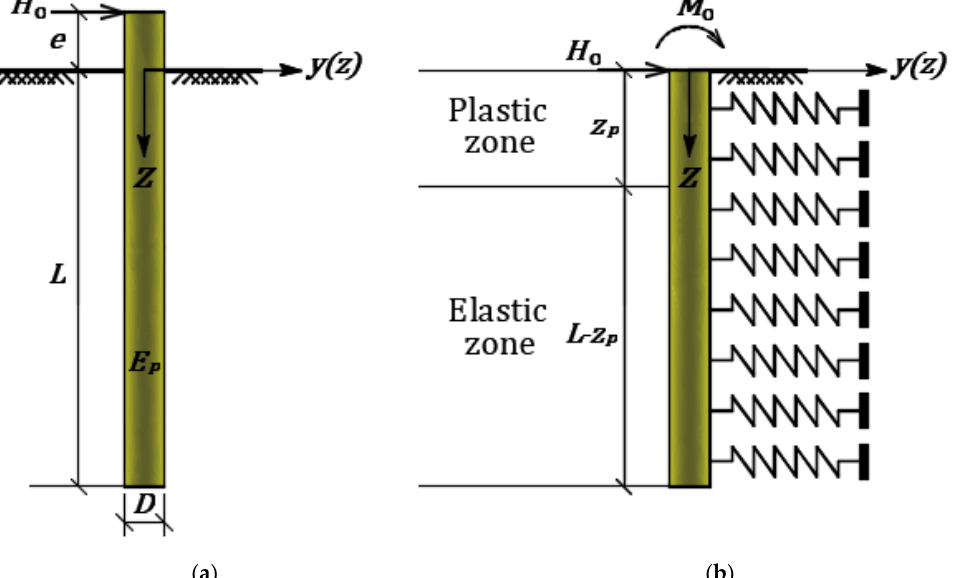
Figure 1. ( a ) Schematic diagram of pile under lateral load, ( b ) illustration of lateral soil reaction distribution along the pile shaft.